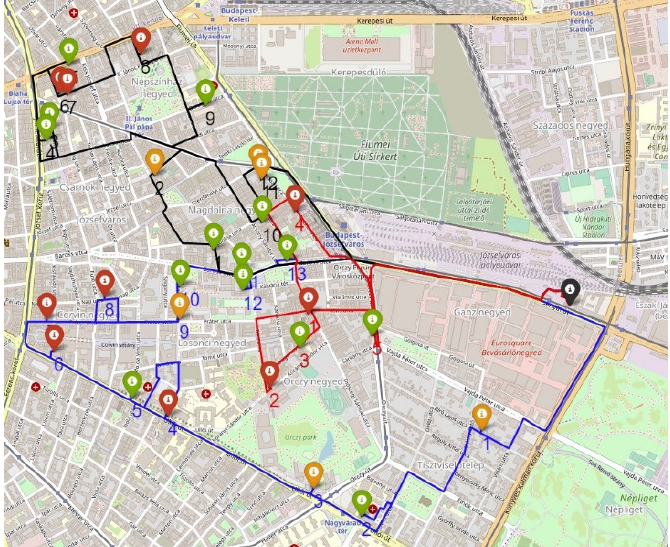
Figure 6. Actual routes when using GA.